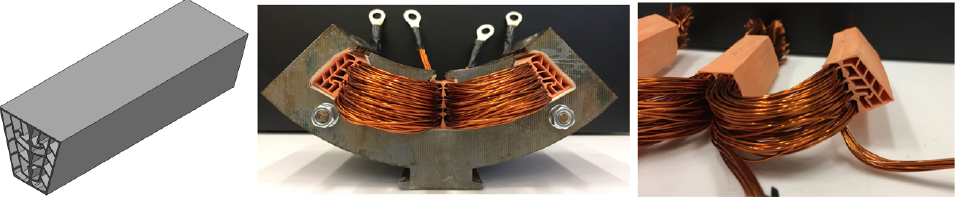
Figure 9. Formers and motorette with fixed conductors’ shape (CASE B); ( Left ) 3D rendering of the slot former, ( Centre ) wound motorette with the slot former, ( Right ) winding in the slot